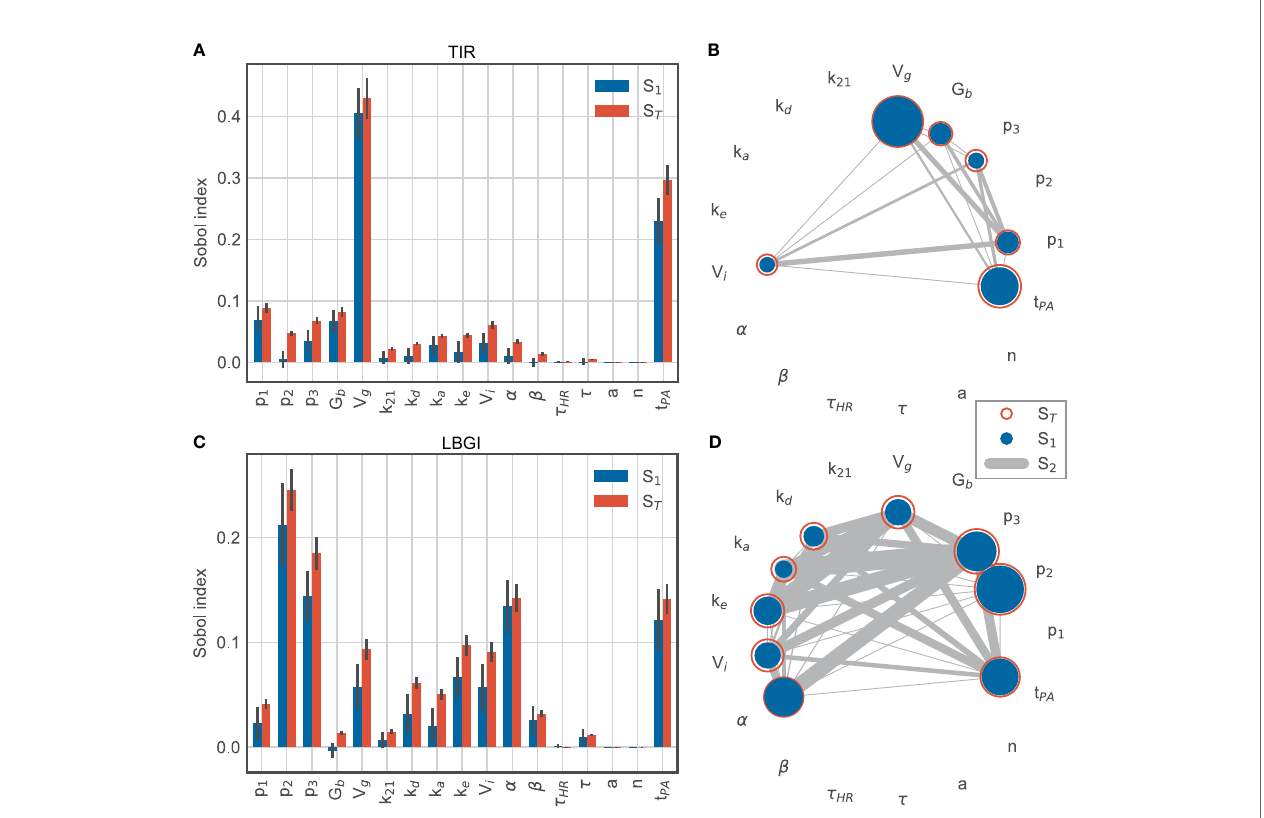
FIGURE 7 | Sobol sensitivity indices for time-in-range (top row) and low blood glucose index (bottom row) for model parameters and exercise timing t PA . (A, C) main effect S 1 and total effect S T . (B, D) second-order effects S 2 for parameters with a minimum total effect of